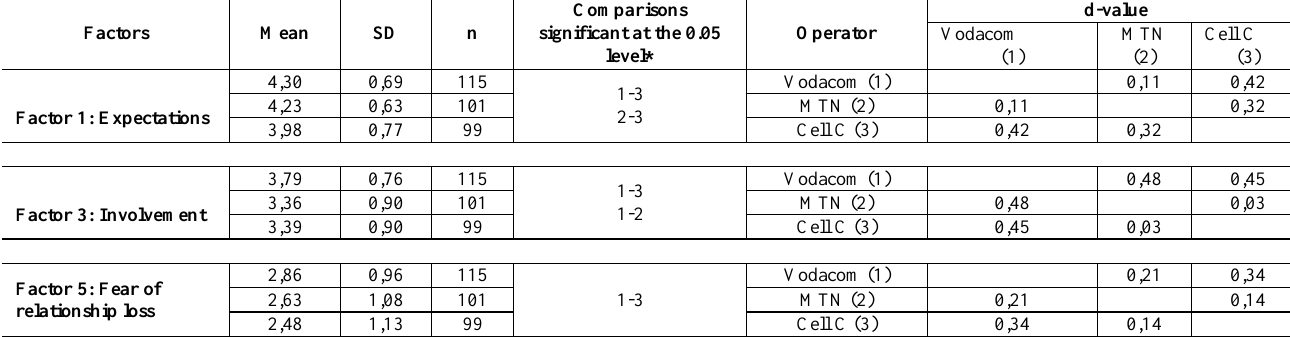
Table 4: Effect sizes of relationship intention towards the three cell phone network operators